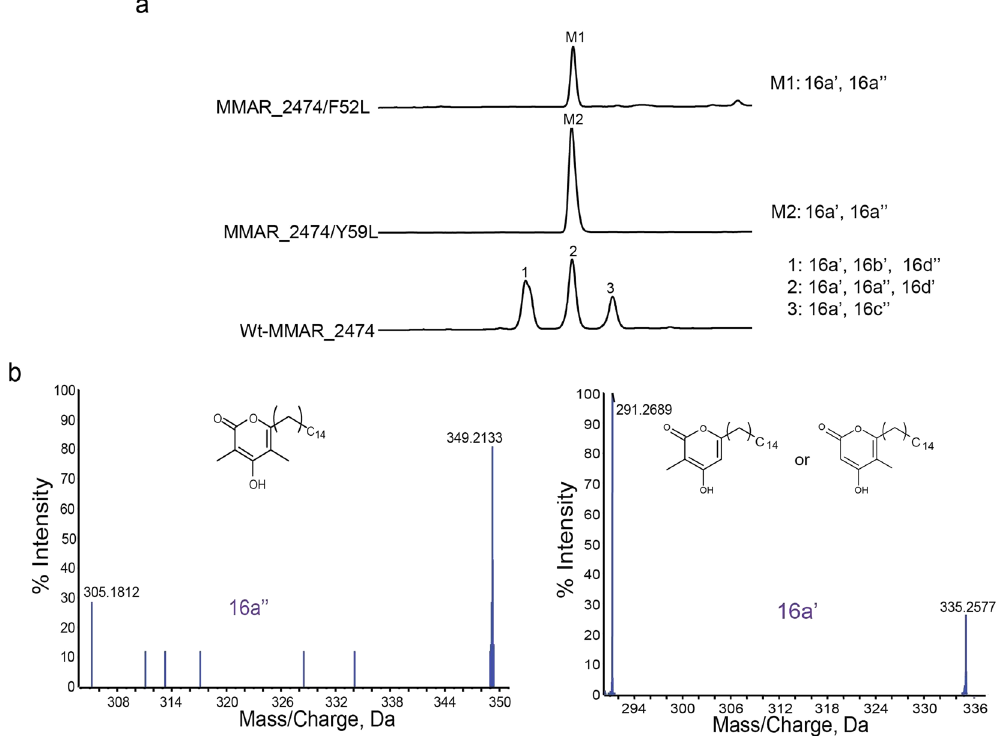
Figure 6. Biochemical characterization of F52L and Y59L mutants of MMAR_2474 protein. ( a ) UFLC chromatograms at 280 nm for reaction products of enzymatic assays carried out with palmitoyl-CoA (C 16 -CoA) as starter substrate and malonyl- and methylmalonyl-CoA as extenders. Reactions carried out with wild-type MMAR_2474 protein were used as control. ( b ) Tandem MS/MS analysis of reaction products of F52L and Y59L mutant